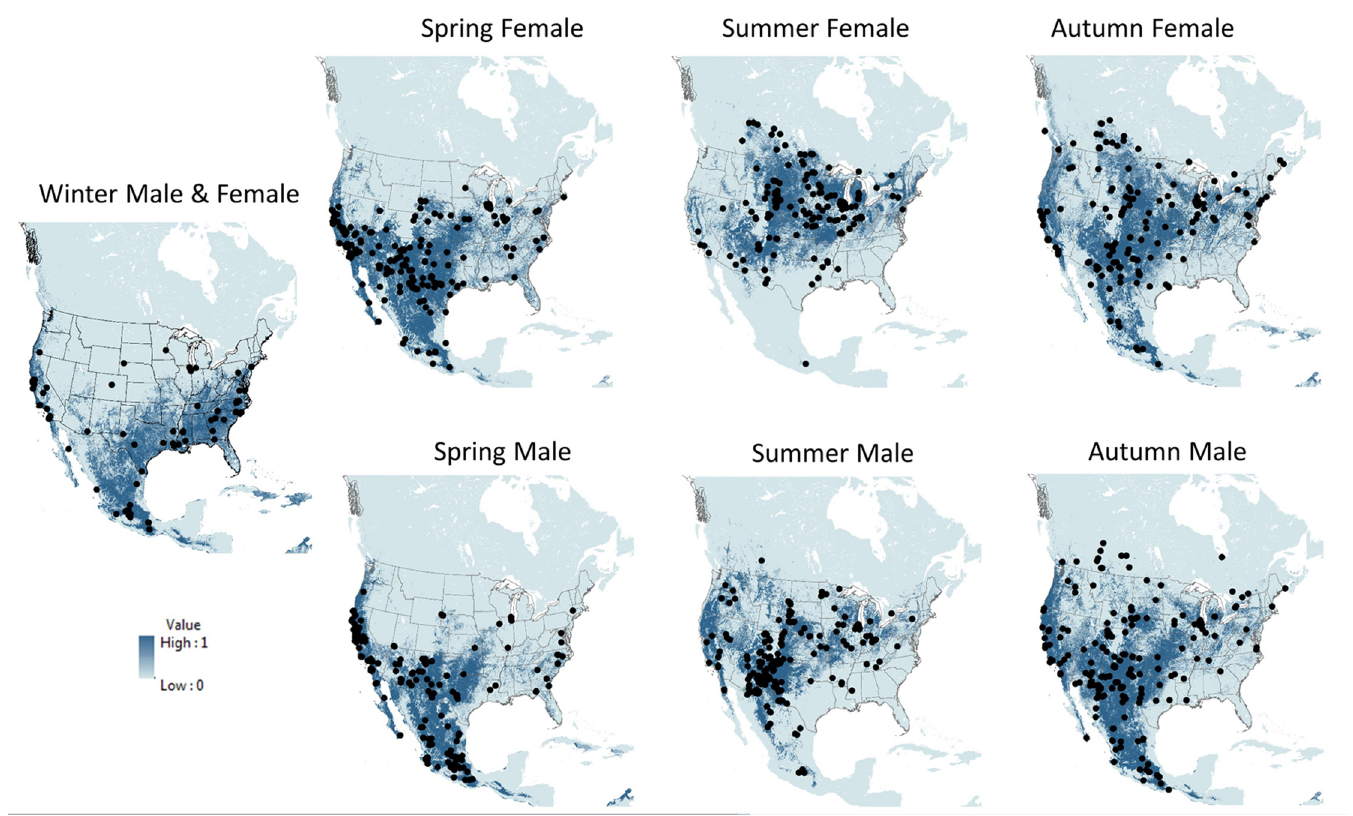
Fig 3. Ensemble maps for each season and sex for North American hoary bats ( Lasiurus cinereus ) using ensemble binary prediction from 5 species distribution model forms. Dots are occurrence record locations for hoary